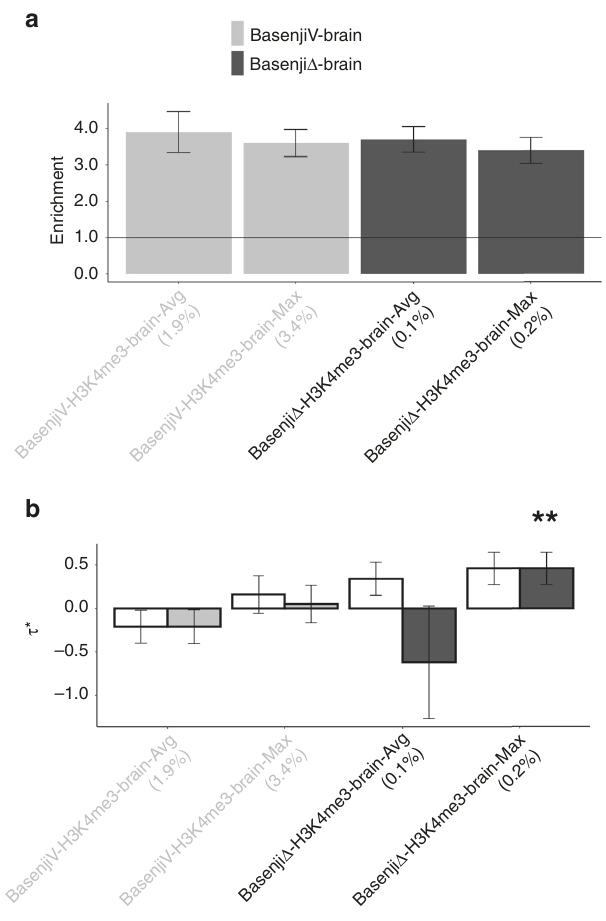
Fig. 3 Disease informativeness of brain-speci fi c allelic-effect deep learning annotations. a Heritability enrichment, conditioned on the brain- speci fi c variant-level joint model and the 1 signi fi cant non-tissue-speci fi c allelic-effect annotation (Basenji Δ -H3K4me3-Max). Horizontal line denotes no enrichment. b Standardized effect size τ ⋆ conditioned on either the brain- speci fi c variant-level joint model and Basenji Δ -H3K4me3-Max (marginal analysis: left column, white) or the same model plus 1 brain-speci fi c allelic- effect annotation (Basenji Δ -H3K4me3-brain-Max) (brain-speci fi c fi nal joint model: right column, dark shading). Results are meta-analyzed across 8 brain-related traits. Results are displayed only for the 2 allelic-effect annotations with signi fi cant τ * in marginal analyses after correcting for 80 (variant-level + allelic-effect) brain-speci fi c annotations tested ( P < 0.05/80), along with the corresponding variant-level annotations; the correlation between the two allelic-effect annotations is 0.78, and the average correlation between the two pairs of variant-level (Basenji) and allelic-effect (Basenji Δ ) annotations is 0.44. For brain-speci fi c fi nal joint model (right column), ** P < 0.05/80. Error bars denote 95% con fi dence intervals. Numerical results are reported in Supplementary Table 21